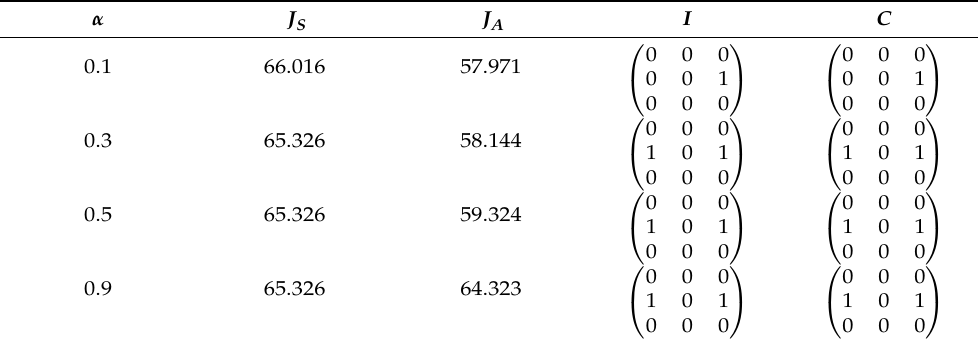
Table 3. Players’ optimal strategies and payoffs in dependence of the value of α